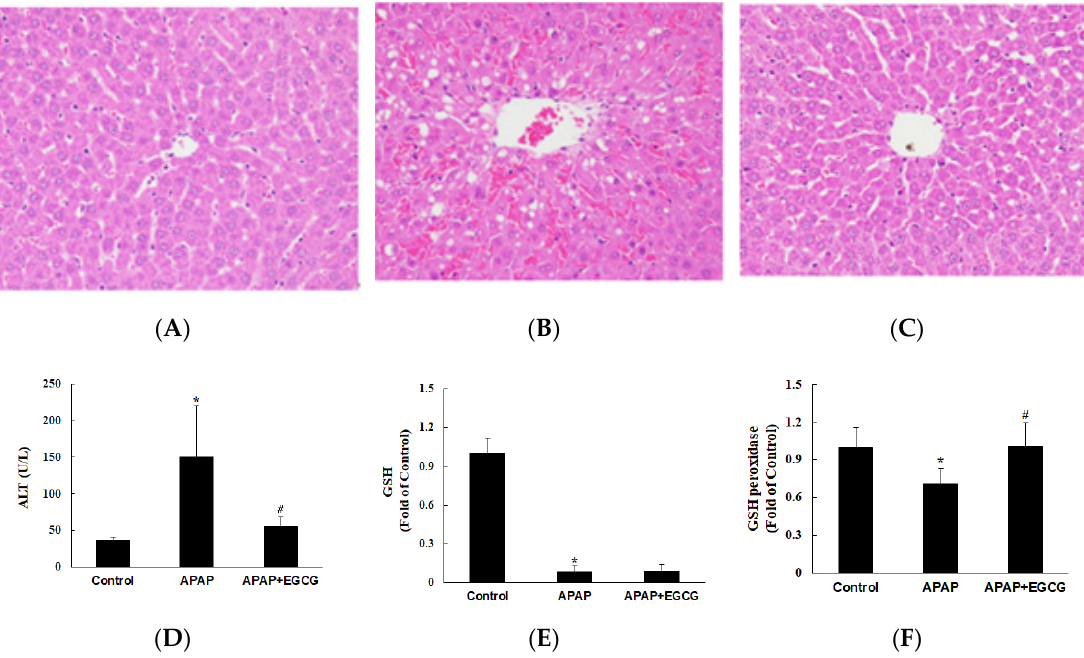
Figure 2. Effects of EGCG supplementation (0.6%) on APAP-induced hepatotoxicity in rats. Histopathological examination of livers was shown in ( A ) the control group, ( B ) the APAP group, and ( C ) the APAP + EGCG group. H&E stain, 400 ×. Normal architecture of the liver was found in the control group ( A ). Multifocal necrosis was graded as slight (2) in ( B ) (APAP group) and minimal (1) in ( C ) (APAP + EGCG group). Plasma alanine aminotransferase (ALT) activity and hepatic